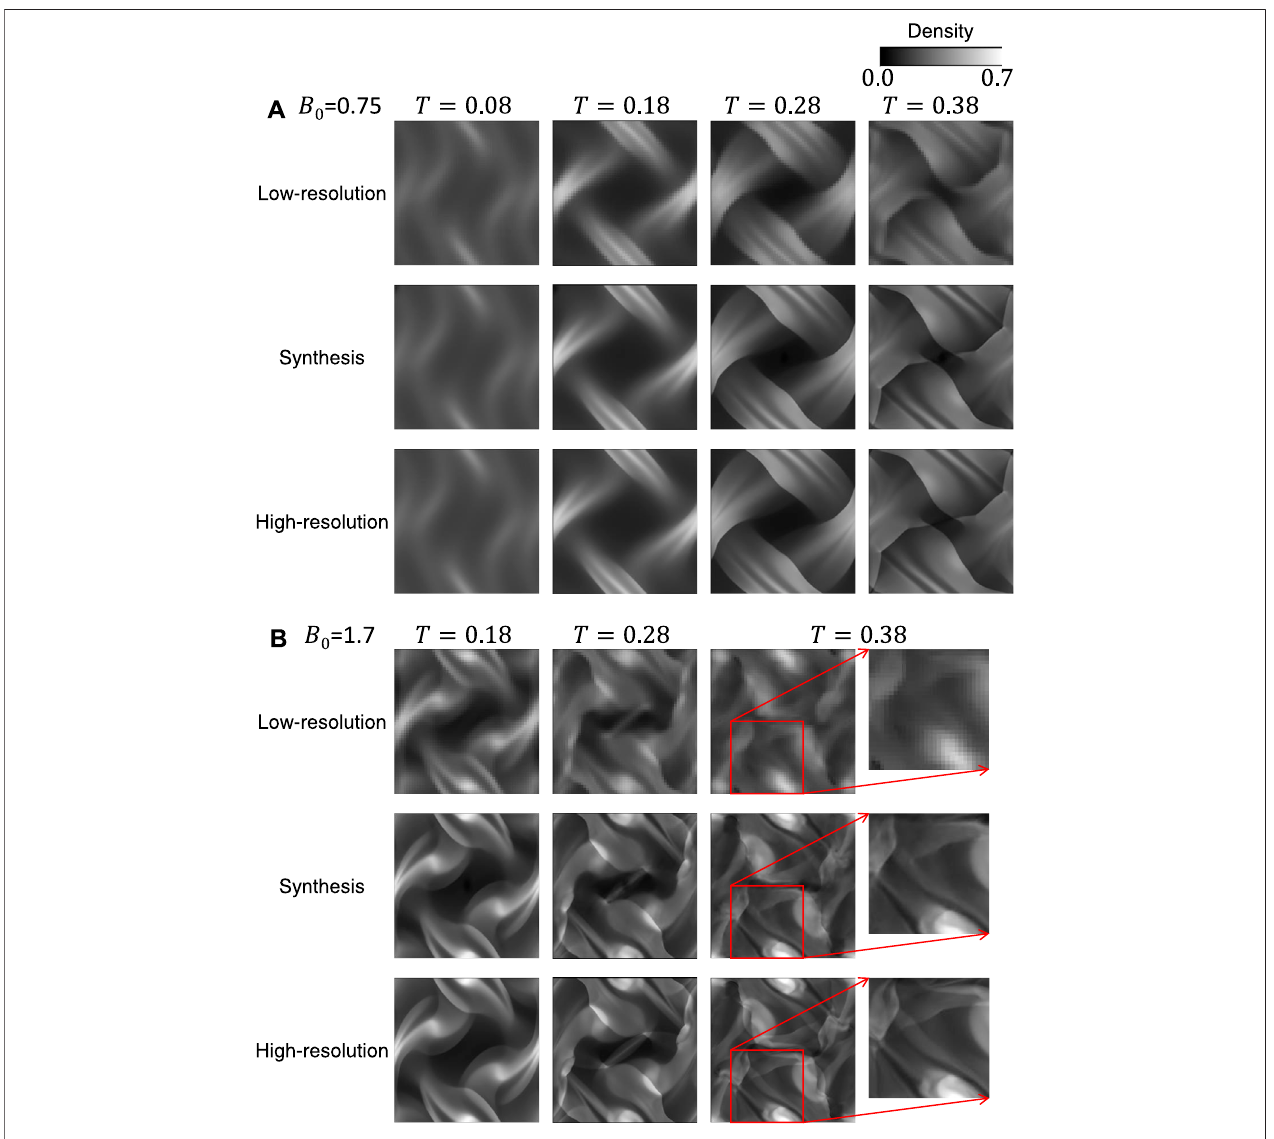
FIGURE 10 | Examples of the time-evolution of density distribution for the testing